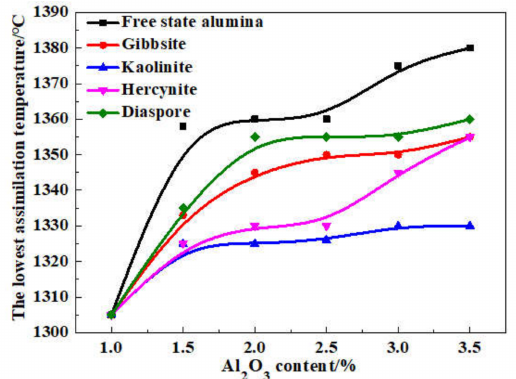
Figure 8. Influence of alumina concentration and type on